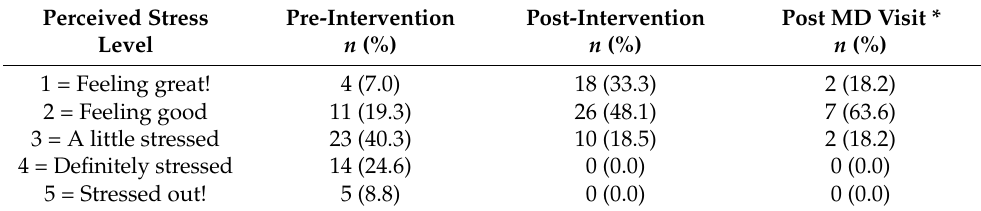
Table 3. Pre- and Post-Intervention Perceived Stress